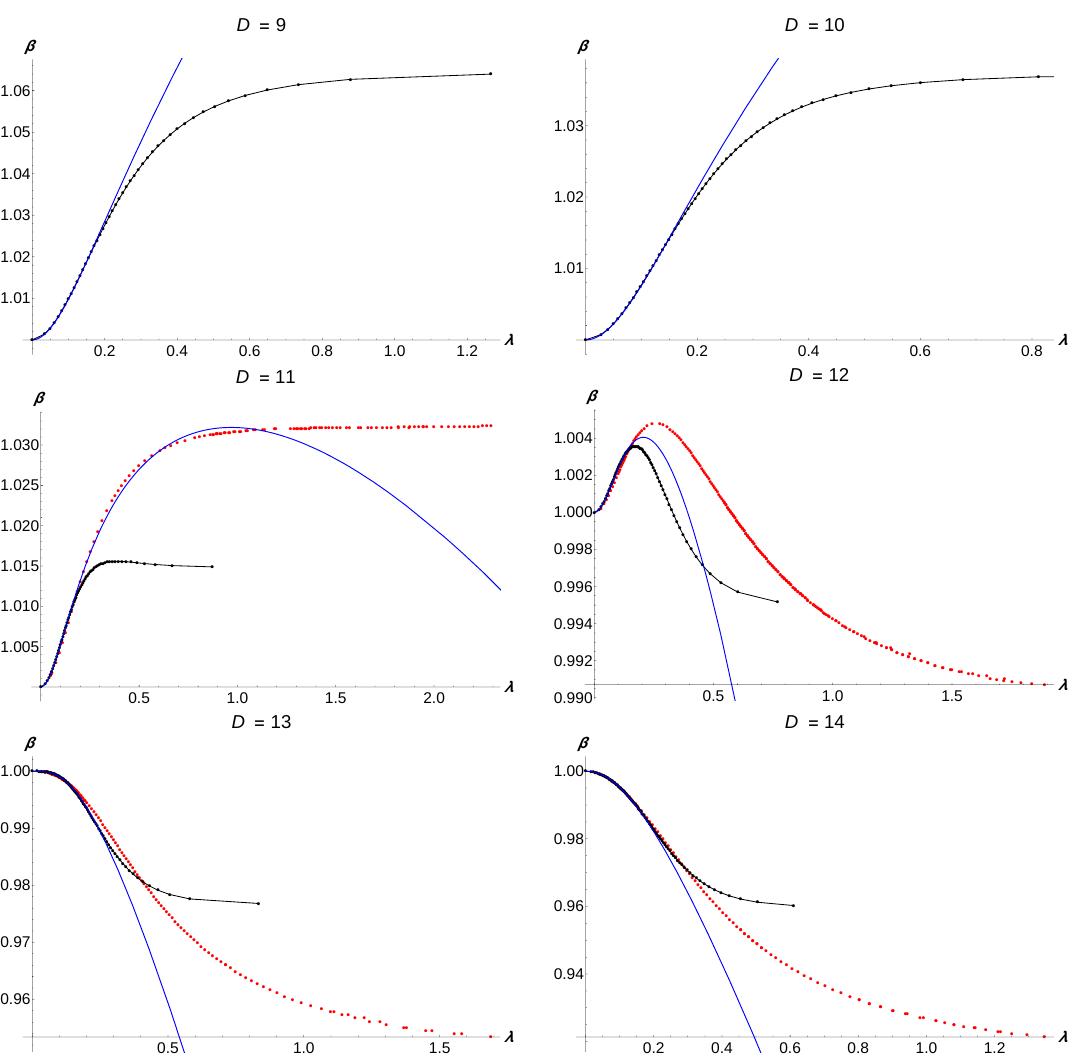
Figure 8 . Inverse temperature (cid:12) vs. deformation parameter (cid:21) . Black dots: large- D numerical results for NUBS. Blue solid: large- D perturbative solution for NUBS. Red dots: (cid:12)nite- D full- numerical NUBS in